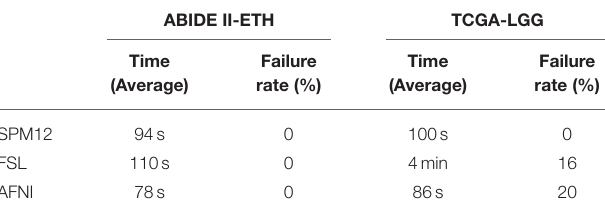
TABLE 3 | Time acquisition and failure rate.